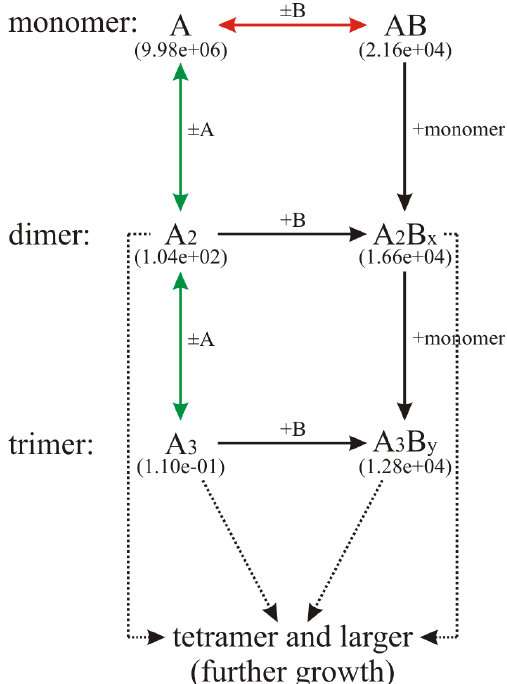
Figure 10. Reaction scheme for the sulfuric acid dimer formation in the ternary system at a low temperature. “A” denotes a sulfuric acid molecule, and “B” an ammonia molecule. “Monomer” is the sum of the concentration of the pure sulfuric acid (A) and the sulfuric acid bound to an ammonia (AB). “Dimer” is the sum of all clusters containing two sulfuric acid molecules (A 2 + A 2 B + A 2 B 2 ) and the same applies for the “trimer” with three sulfuric acid molecules. The arrows indicate the relevant reactions and whether only colli- sional growth (single-ended arrow) or growth as well as evaporation (double-ended arrow) is important. Losses due to walls, dilution, and coagulation are included in the model but not indicated. Small numbers represent concentrations for an example calculation at a temperature of 248K, a [monomer] of 1 × 10 7 cm − 3 , and a [NH 3 ] of 2 × 10 8 cm − 3 . See text for